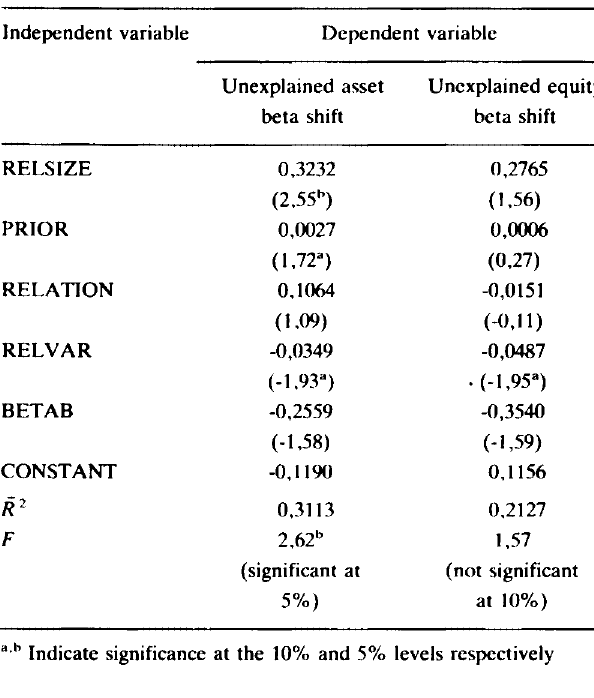
2 Ordinary least squares estimates coefficients of equation (3) (t statistics in parenthesis) Dependent